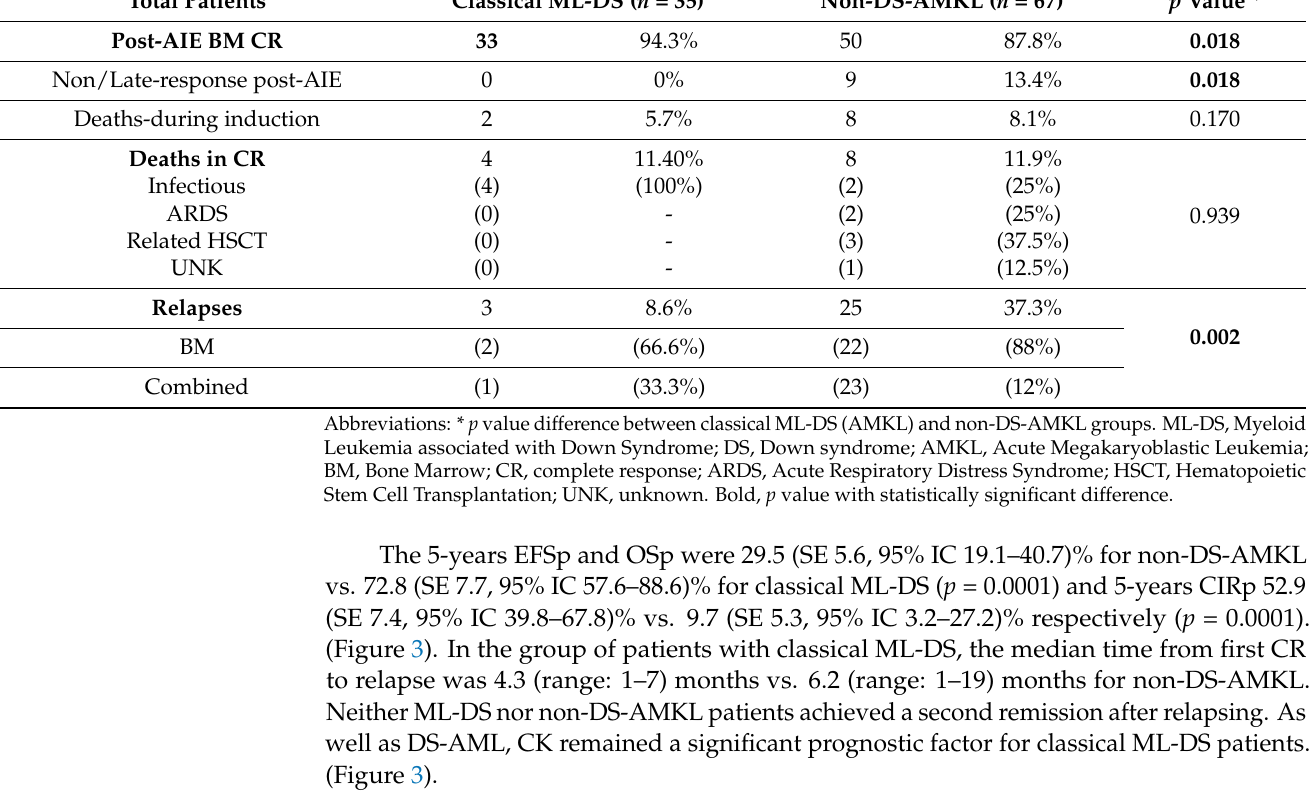
Table 3. Outcome comparison between classical ML-DS (AMKL) and non-DS-AMKL. Total